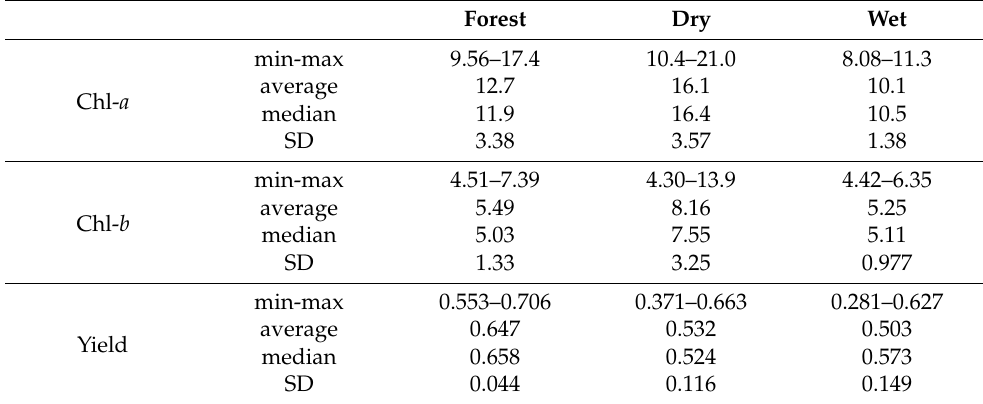
Table 1. Chlorophyll a and b content [mg/L] and actual photochemical efficiency (yield) [-] in mosses depending on the living conditions.